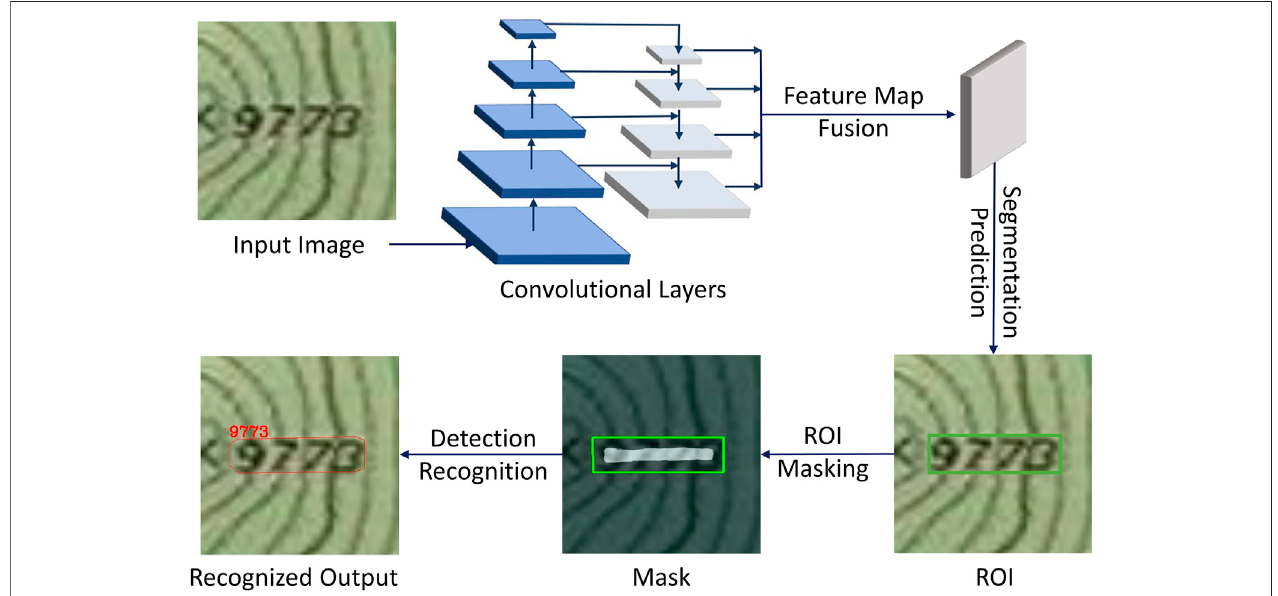
FIGURE1| MaskTextSpotterV3work fl owstartingwithinputimage,whichisconvolvedthroughmultiplelayerstoproducefeaturemaps.Featuremapsarefused, segmented, masked, and the text characters recognized.